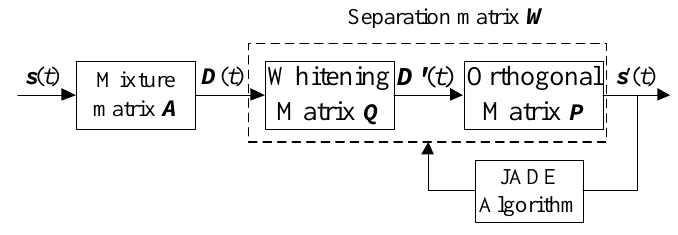
Figure 1. Schematic diagram of the JADE blind source separation algorithm.